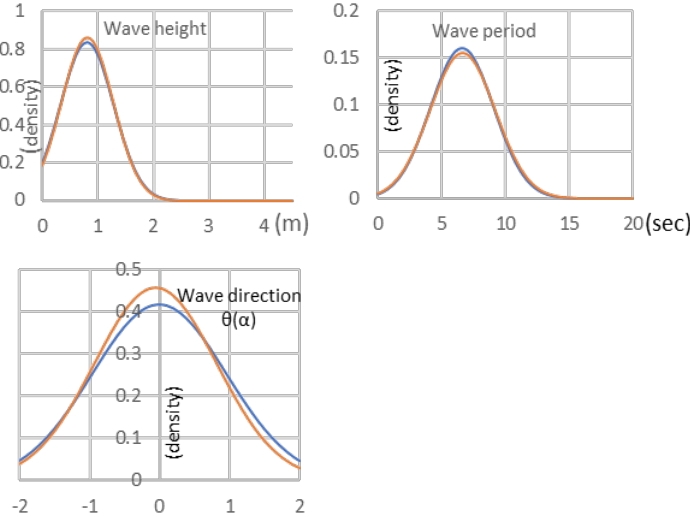
Figure 8. In the time period: 1 July 2003 to 31 March 2013, density function plots for the observed and simulated wave height (m), wave period (s) and wave direction (dimensionless transformed) respectively. Blue curves correspond to observed data and red curves correspond to simulated data. Similarly, blue and red vertical lines correspond to the means of the observed and simulated data, respectively.